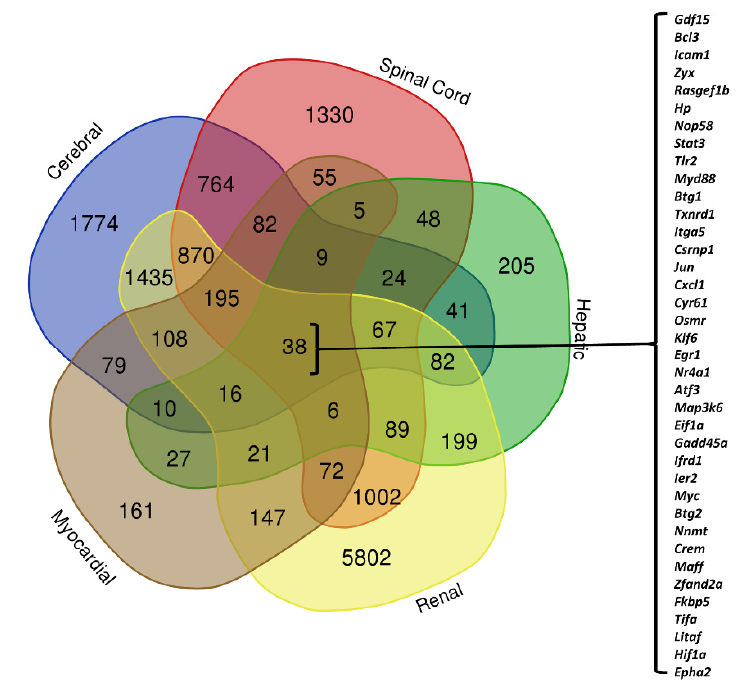
Figure 4. Venn diagram of all included DEGs categorized based on source organ. The values represent the number of DEGs in each division (details of diagram in Table S2).